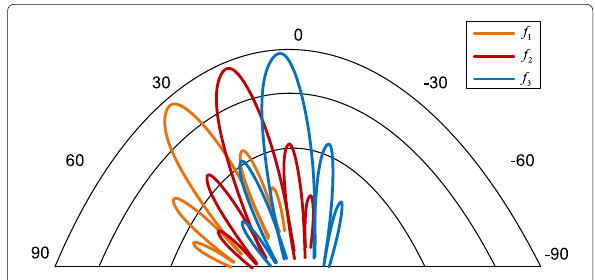
Fig. 2 The frequency-dependent AoA/AoD problem (beam squint) in the wideband system. Each color denotes a different frequency